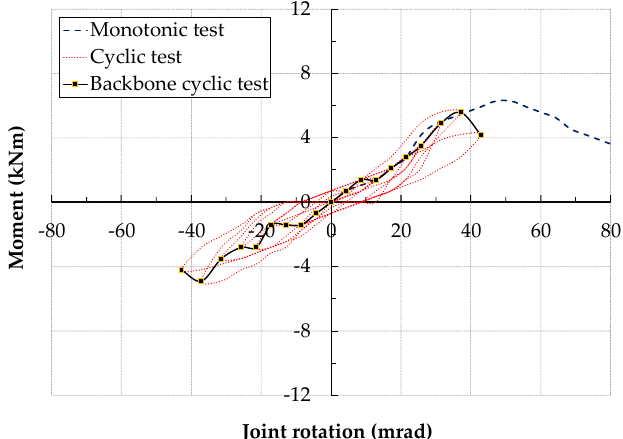
Figure 4. Cyclic moment-rotation response: SFSc2-bolted joint with double web and flange steel cleats.